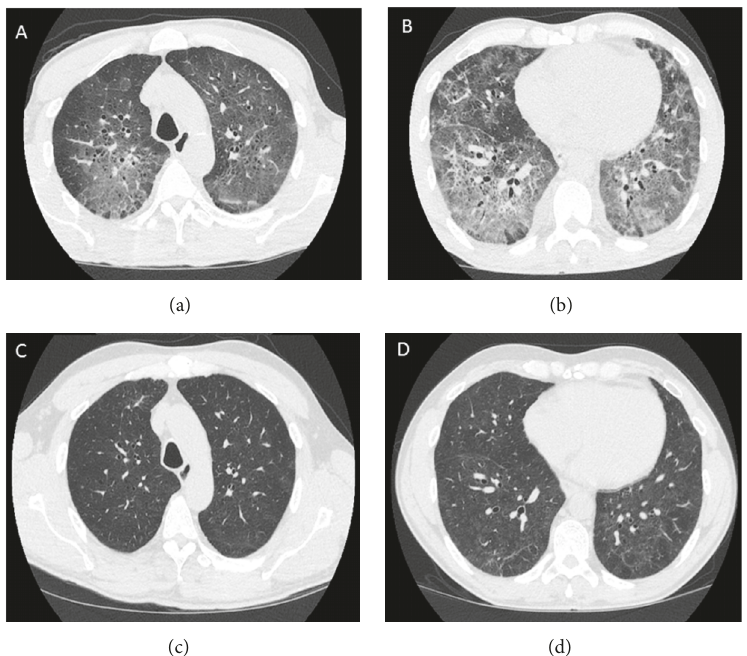
Figure 3: (a) and (b) At the time of presentation, axial computed tomography of the chest images show upper lobe predominant ground glass attenuation, mild interlobular septal thickening and small cysts. (c) and (d) Eight weeks following treatment, axial computed tomography of the chest images shows near complete resolution of ground-glass attenuation, interlobular septal thickening and